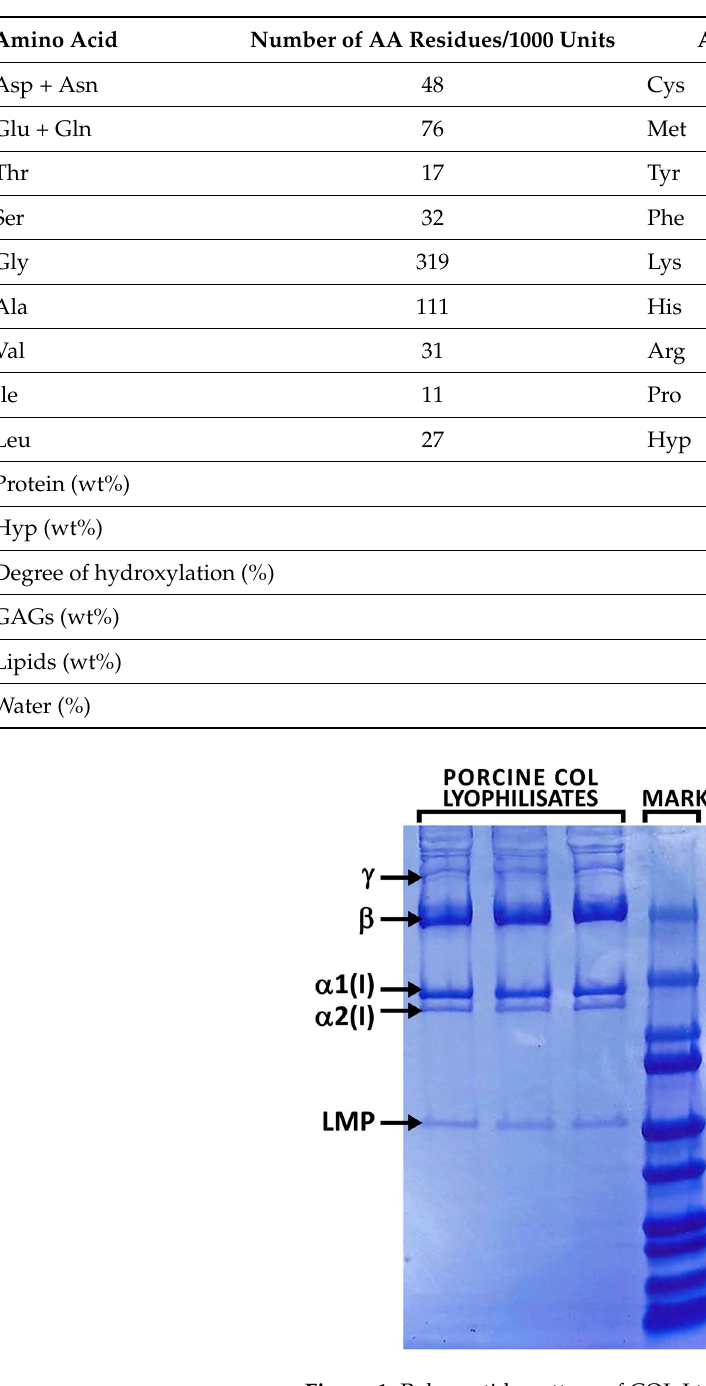
Table 1. Composition of COL lyophilizate isolated from porcine skin. “*” marked lower and upper quartile.